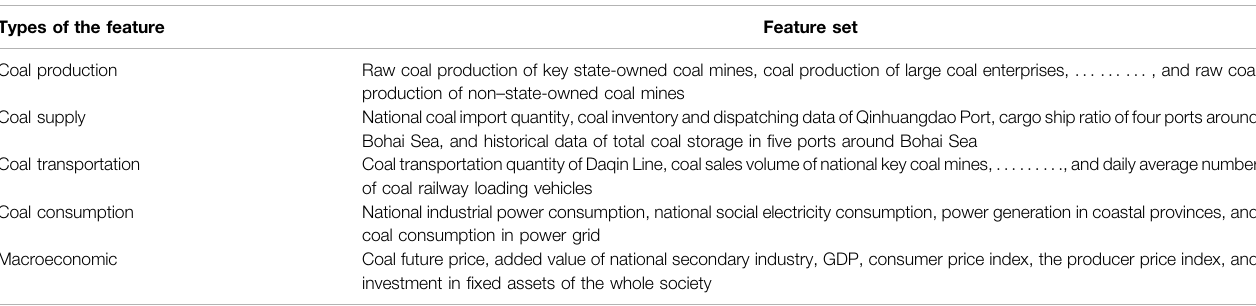
TABLE 1 | Selection of steam coal feature data.